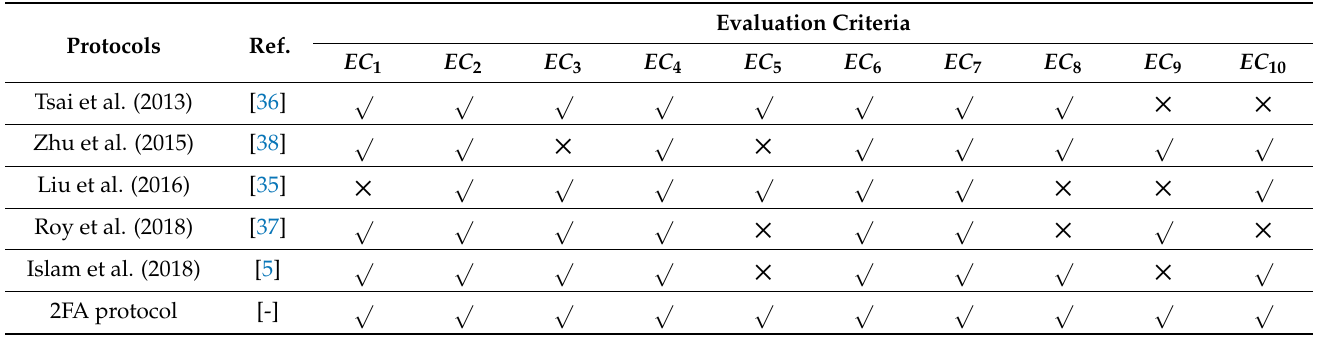
Table 6. Functionality comparison of relevant AKA